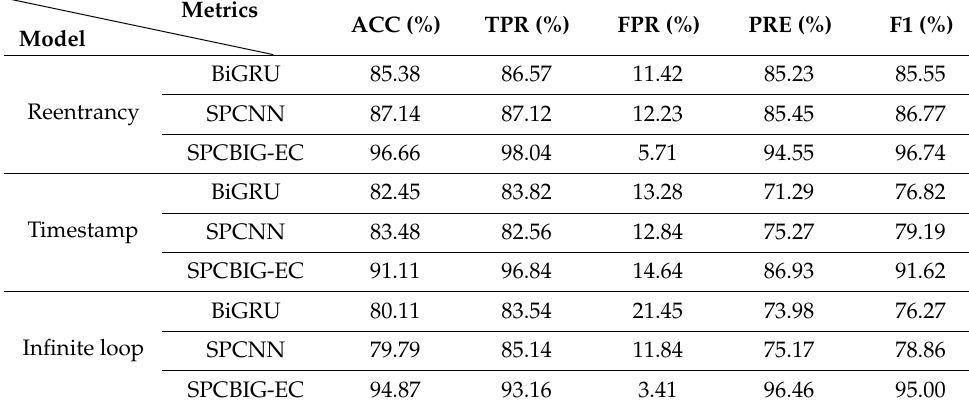
Table 4. Performance comparison of a single model and serial hybrid model.